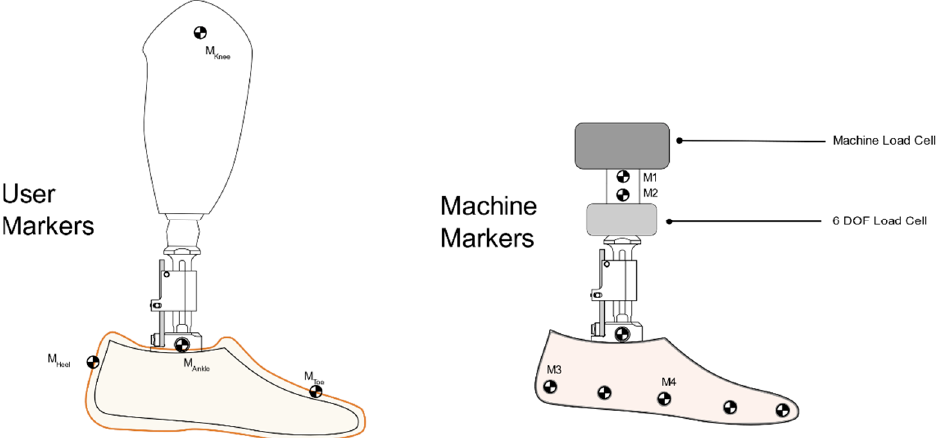
Figure 5. Schematic of marker positions used for the functional joint center: (left) user test and (right) machine test.